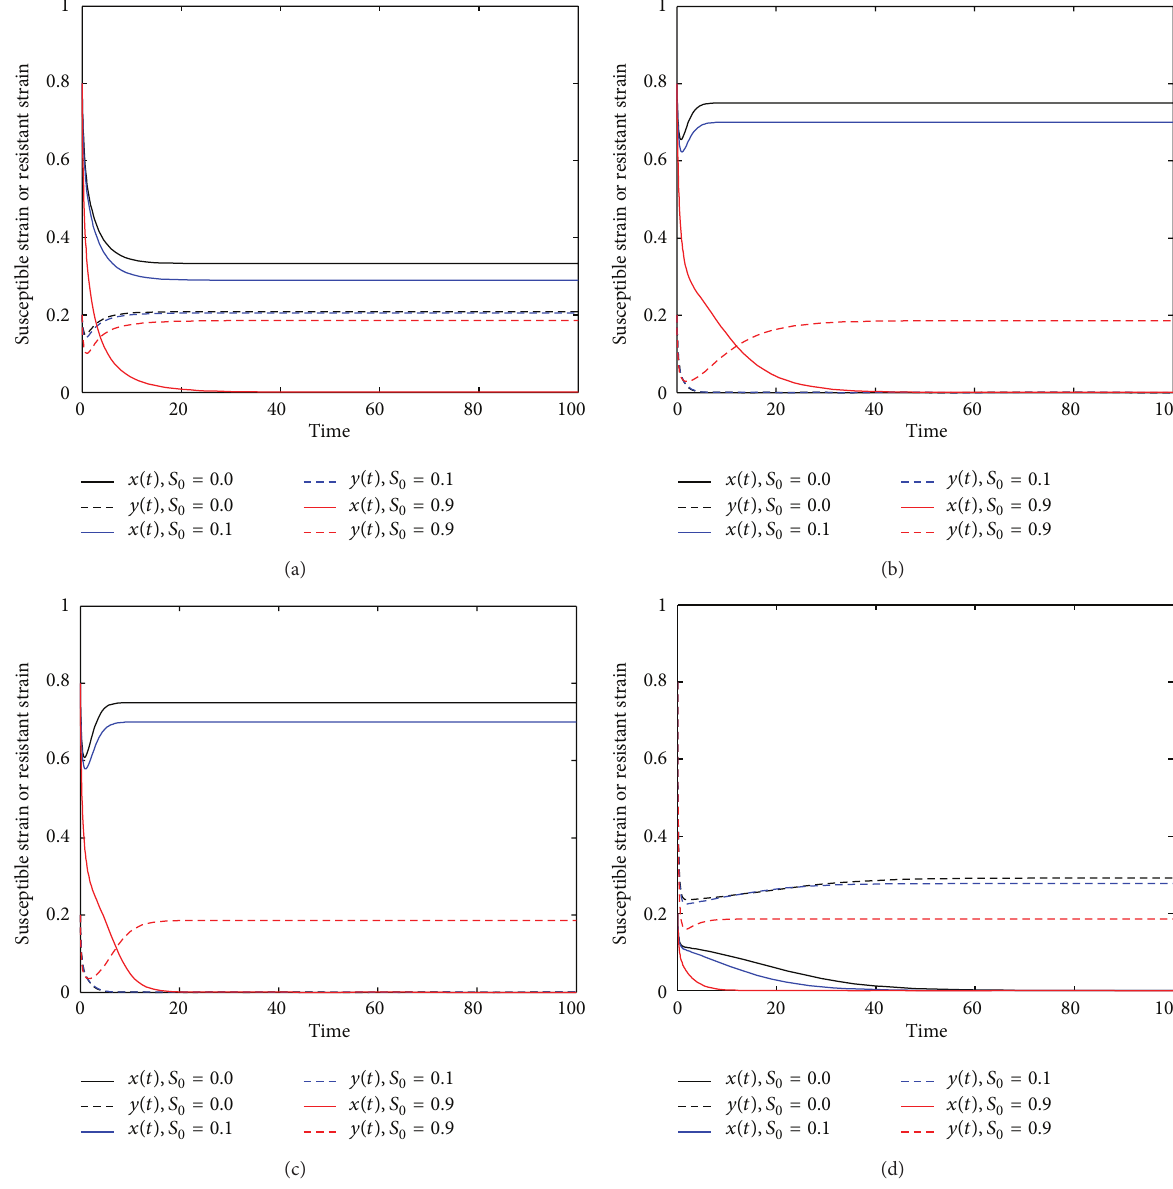
Figure 2: Time series of the susceptible strain (𝑥(𝑡)) and resistant strain (𝑦(𝑡)) within host as predicted by the model (1). 𝛿 12 = 4.0 and = 3.0 in (a); 𝛿 = 4.0 and 𝛿 = 6.0 in (b); 𝛿 = 5.5 and 𝛿 = 6.0 in (c) and (d). The initial condition is (𝑥(0),𝑦(0)) = (0.8, 0.2) in (a), 𝛿 21 12 21 12 21 (b), and (c), and (𝑥(0),𝑦(0)) = (0.2, 0.8) in (d). Other parameters are shown in